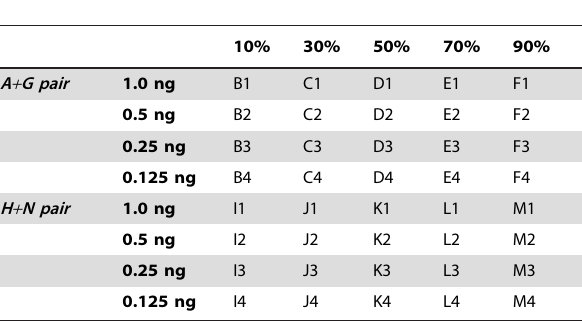
Table 1. Forty DNA mixture samples were used in the